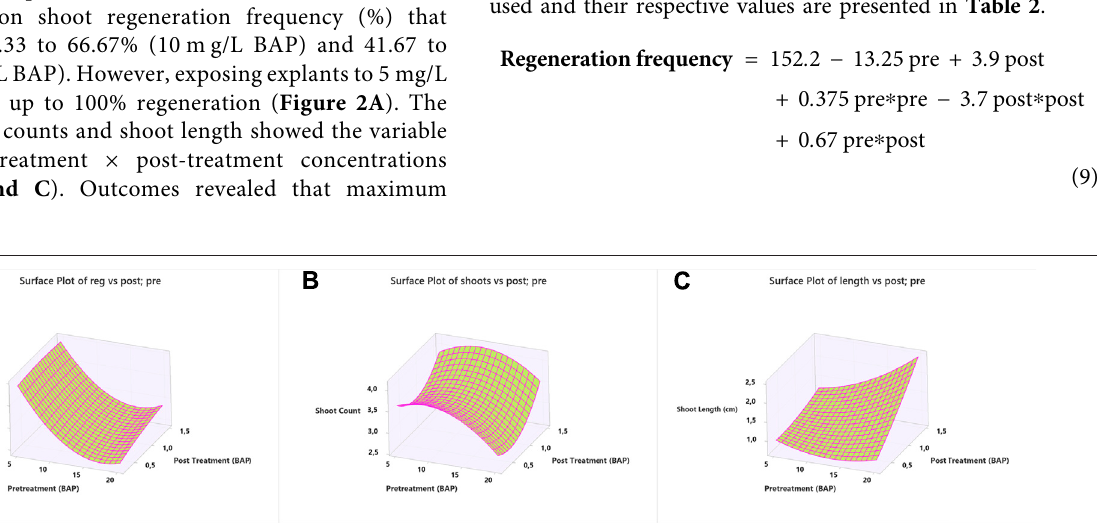
Frontiers in Genetics |